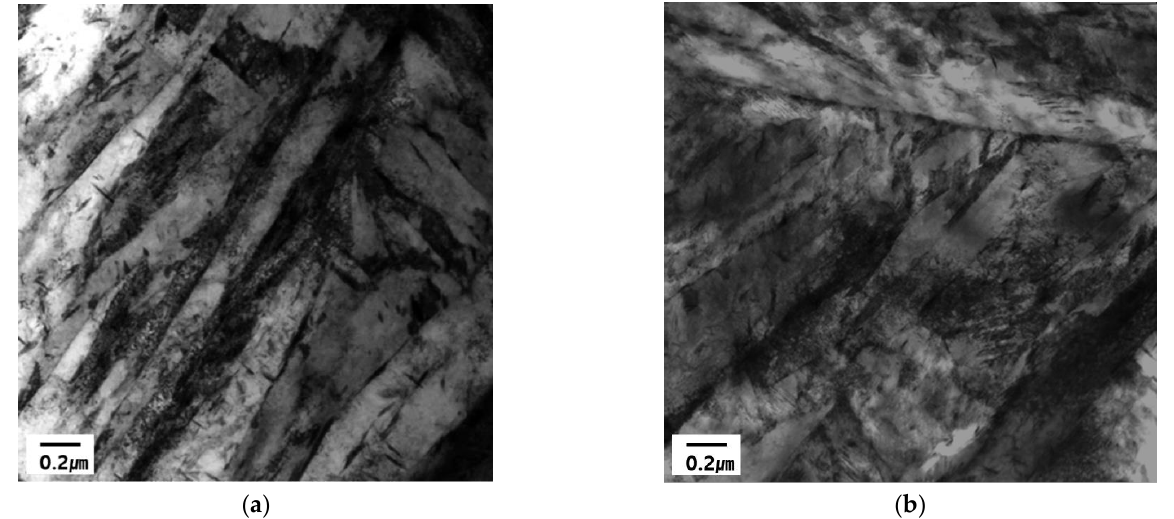
Figure 10. TEM image of hot-stamped boron steel: ( a ) 1.5 GPa and ( b ) 1.8 GPa grade specimens.